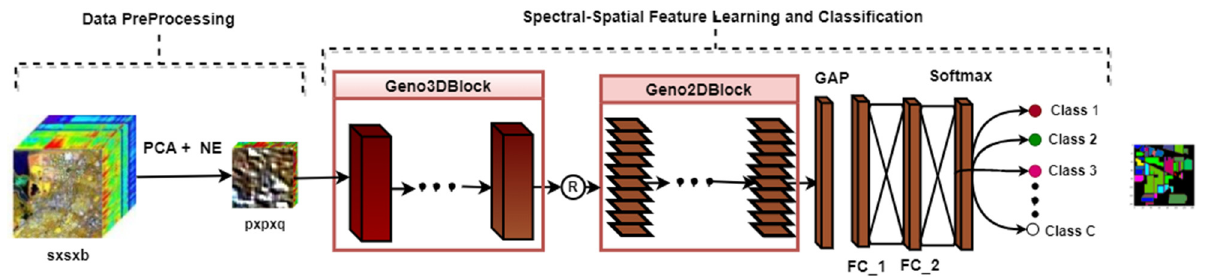
Figure 1. The framework of the proposed HybridGBN Model Variants.